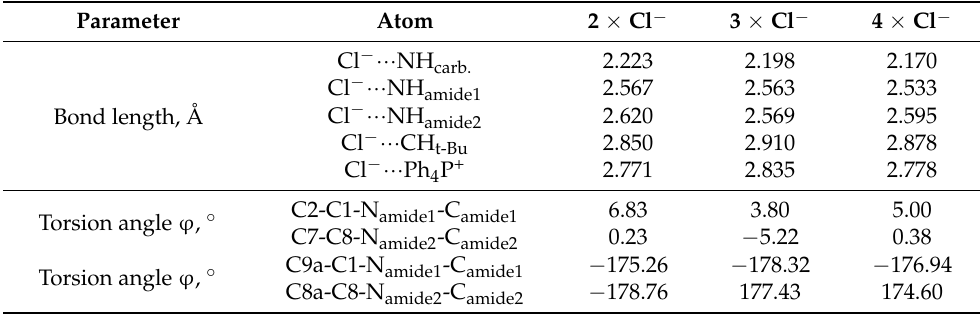
Table 1. Hydrogen bonding distances and selected torsion angles in the X-ray crystal structures of chloride complexes of 2 , 3 and 4 .